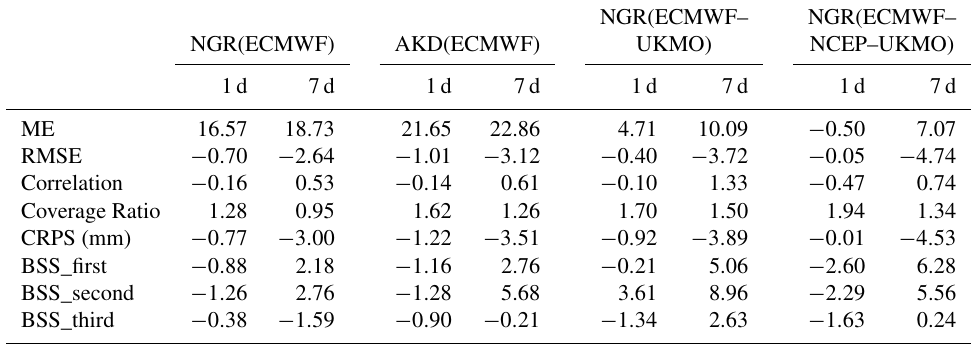
Table A2. Percentage differences (averaged over regions) of forecast performance using a 45d training period compared with using a 30d training period for lead times of 1 and 7d. See the caption of Table 1 for an explanation of the